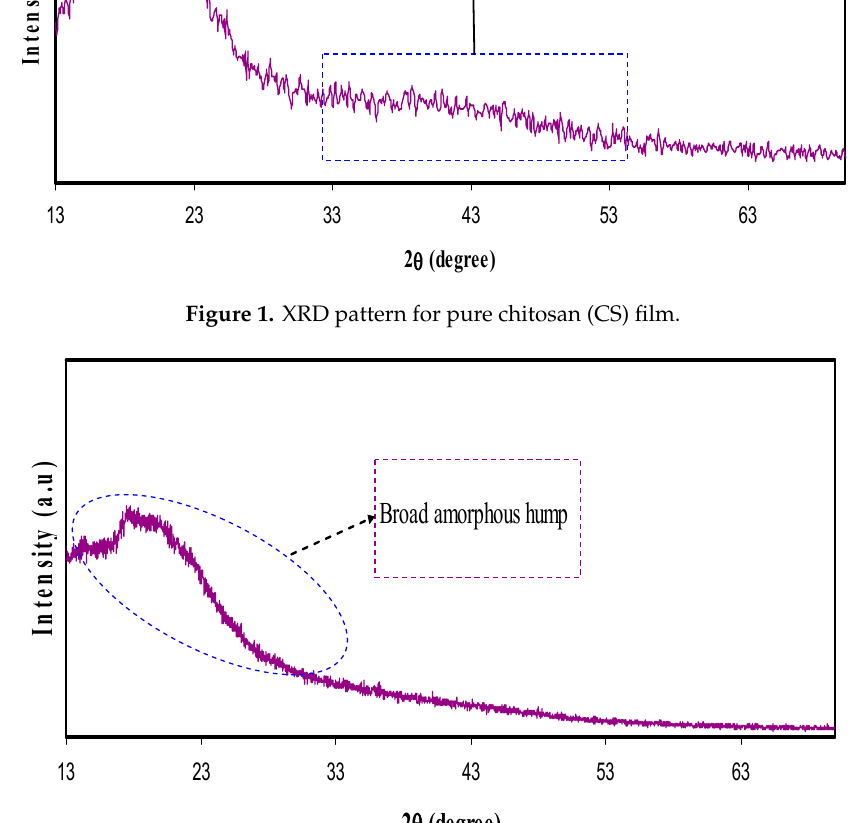
Figure 2. XRD pattern for chitosan: poly (2-ethyl-2-oxazoline) (POZ) polymer blend film.